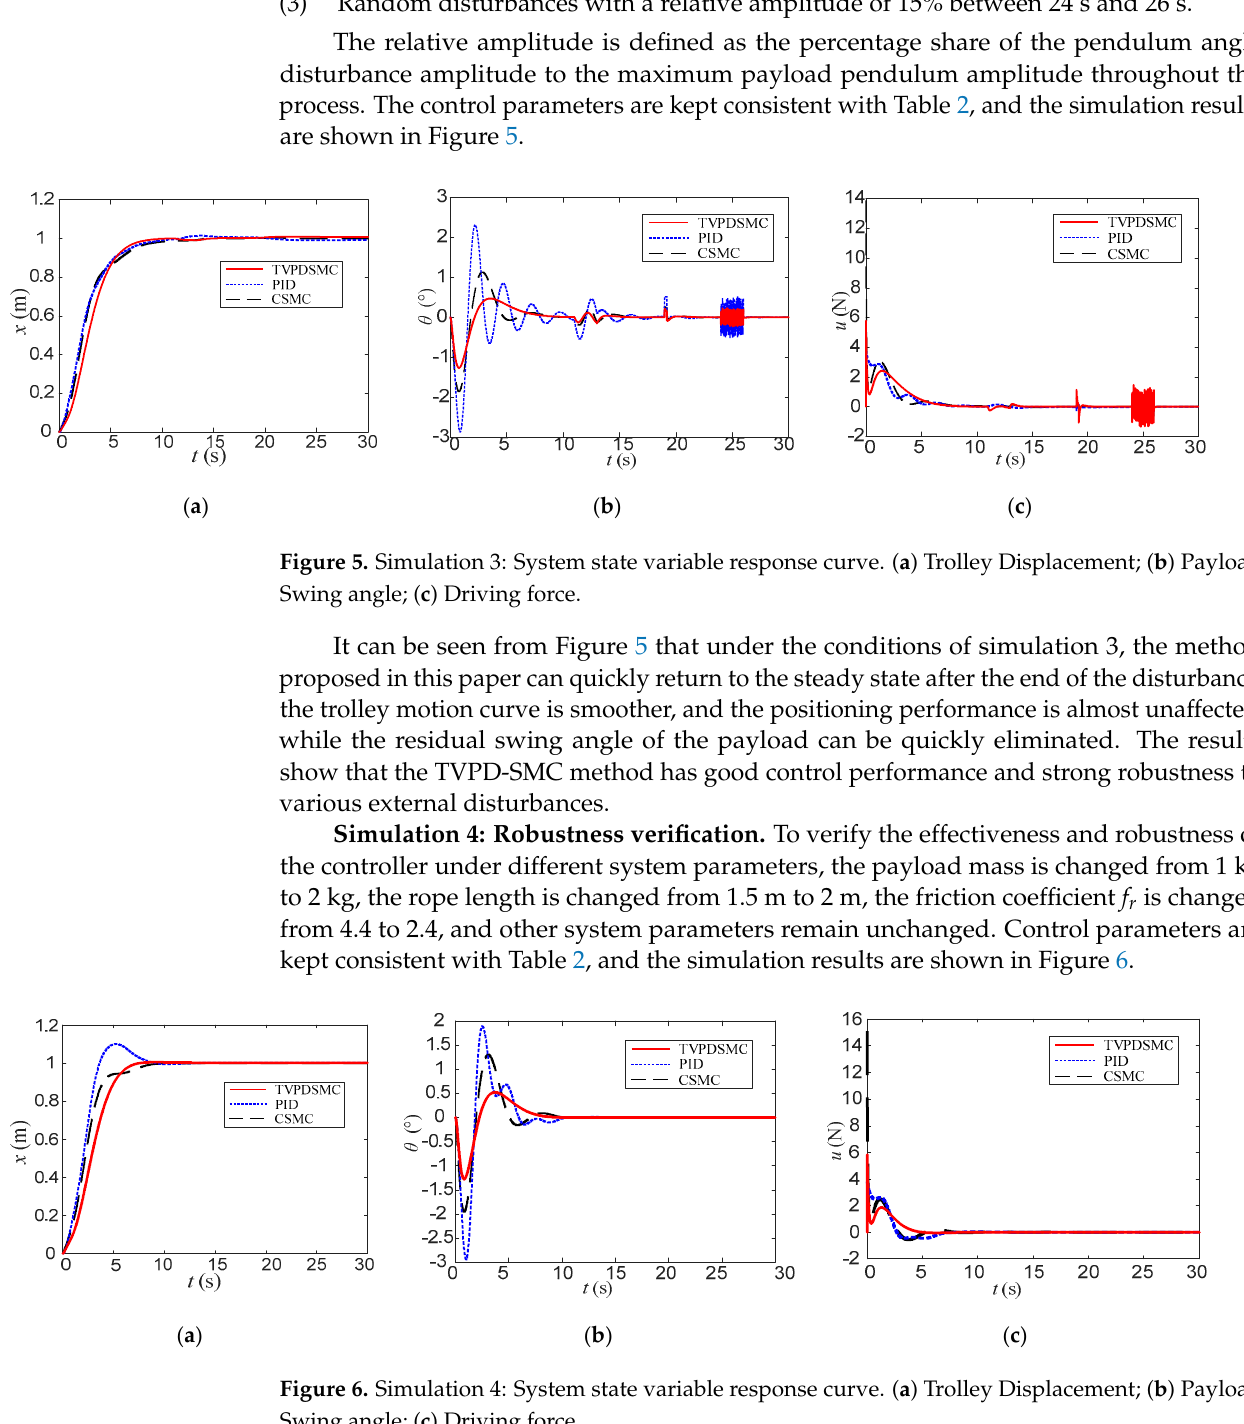
(c) Figure 4. Simulation 2: System state variable response curve. ( a ) Trolley Displacement; ( b ) Payload Swing angle; ( c ) Driving force.